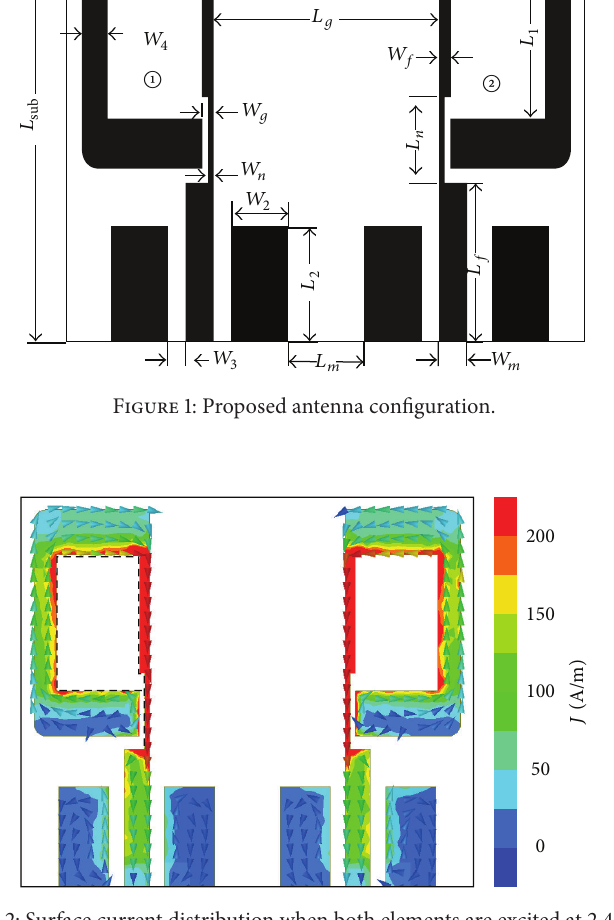
Figure 2: Surface current distribution when both elements are excited at 2.45